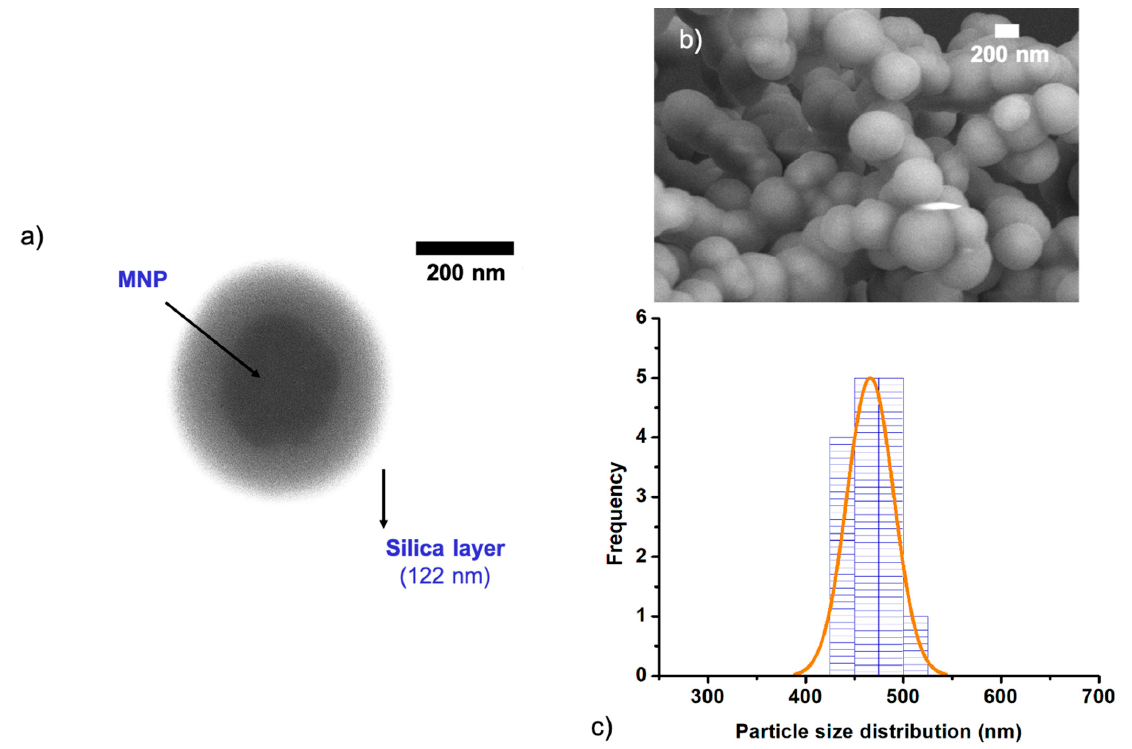
Figure 7. ( a ) TEM image of the sample P (0.1 mg/mL of MNPs), showing the thick silica layer around the dark iron-oxide core. ( b ) SEM image of sample P. ( c ) The particle size distribution of sample P.